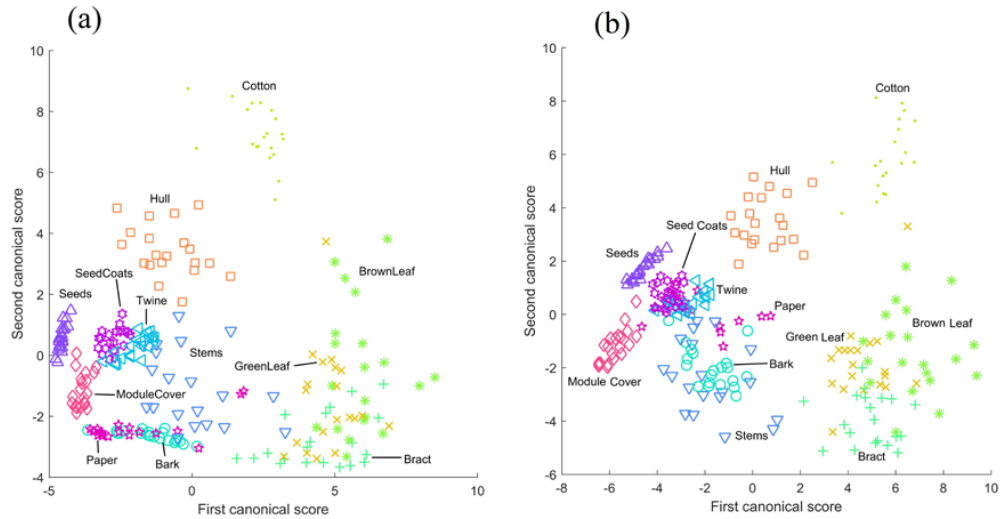
Figure 12. Canonical discriminant analysis scores plots from feature sets. ( a ) waveform features; ( b ) amplitude features.